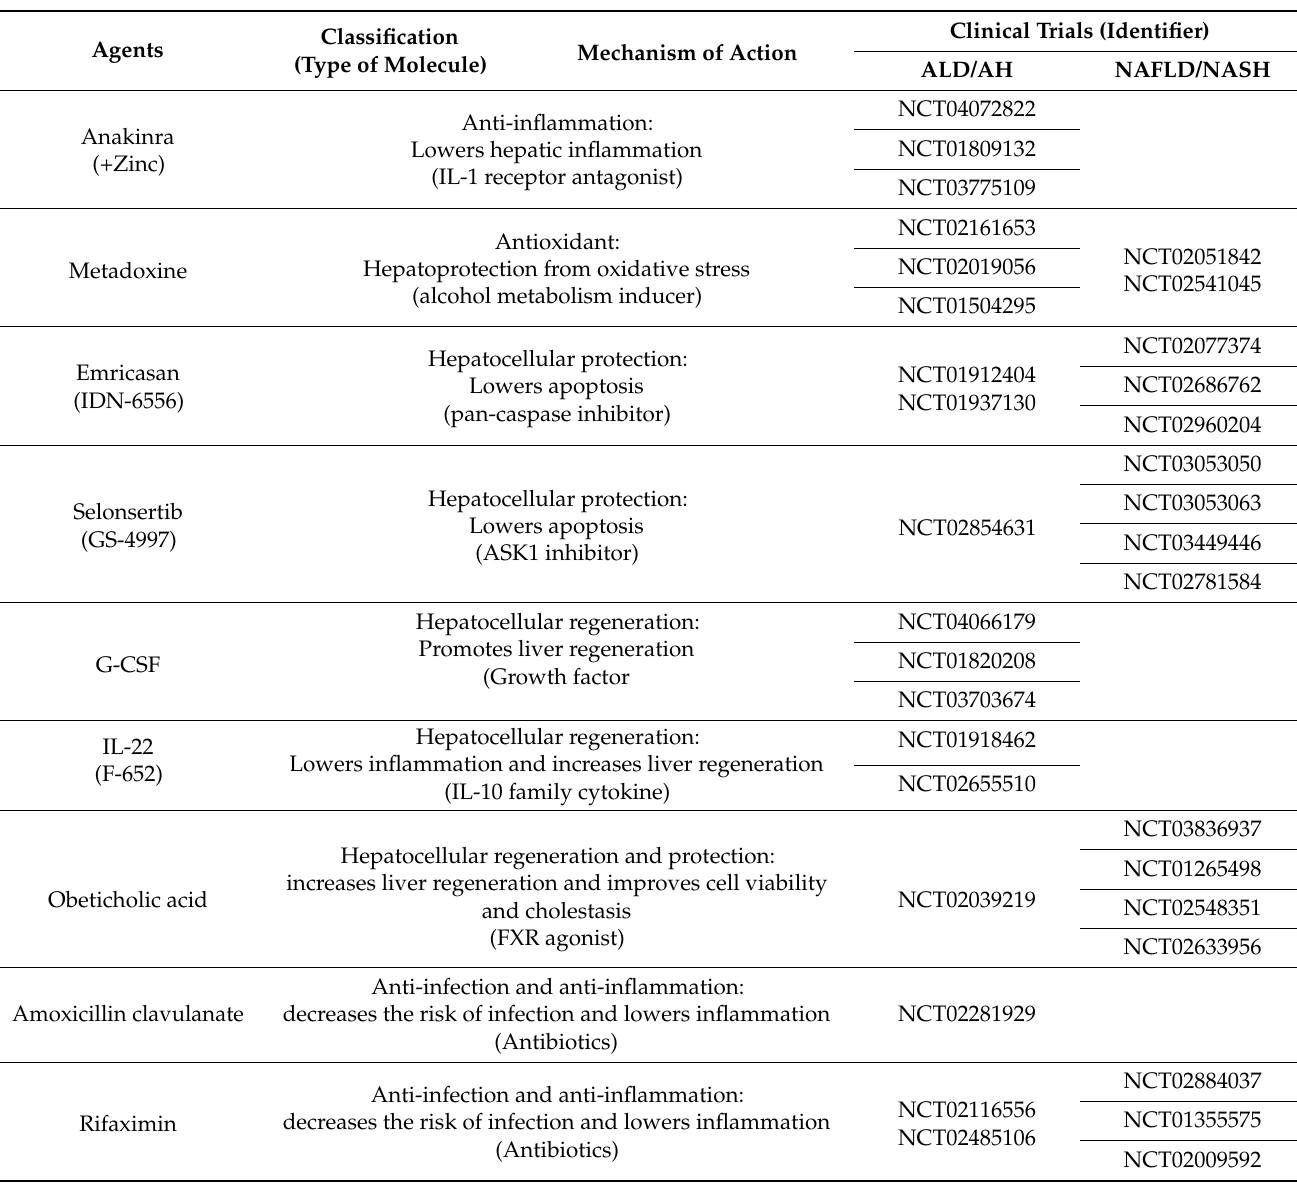
Table 2. Recent therapeutic molecules and related clinical trials for the treatment of ALD/AH and